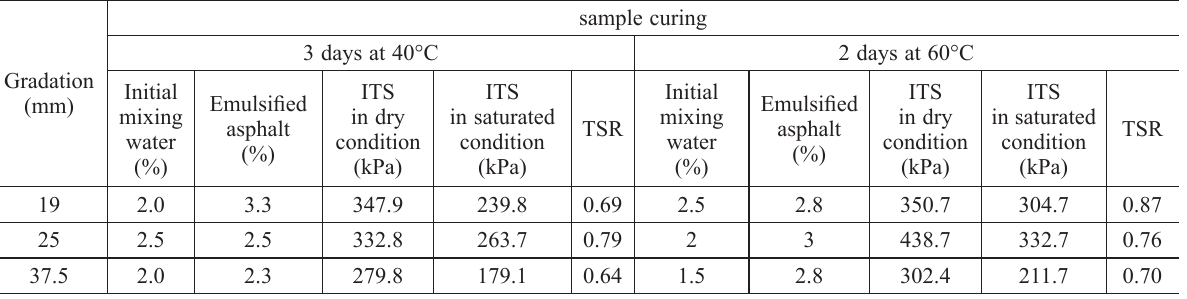
Table 4. The summary of indirect tensile strength in 19, 25 and 37.5 mm gradations for optimum mixes in two curing conditions